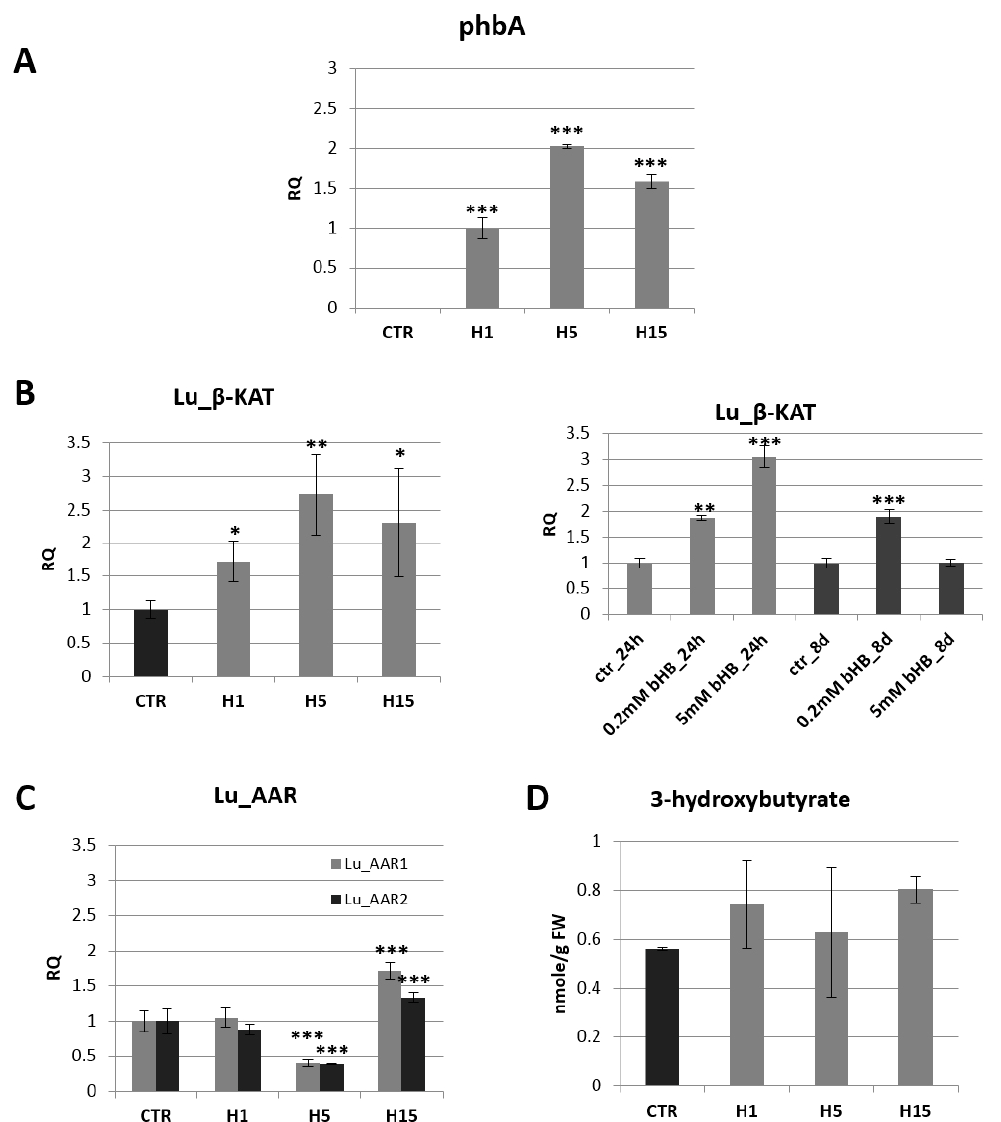
Figure 1. The mRNA level of bacterial beta-ketothiolase (phbA) in transgenic flax plants (H1, H5, H15). Changes in mRNA levels are shown as the relative quantity (RQ) relative to the reference gene ( actin ) in comparison with the expression in H1 plants, where it was the lowest. Non-transgenic control lines (CTR) showed not phbA gene expression. The results were obtained via PCR on cDNA, subsequent electrophoretic separation of obtained products and the densitometric measurement of bands ( A ). The mRNA level of endogenous beta-ketothiolase in transgenic flax lines H1, H5, H15 in comparison with non-transgenic flax (CTR) and in flax treated with the beta-hydroxybutyrate standard at concentrations of 0.2 mM and 5 mM during 24 h and 8 days in relation to non-treated flax (CTR) ( B ). The mRNA level of acetoacetyl-CoA reductases in transgenic flax lines H1, H5, H15 in relation to non-transgenic flax (CTR). The mRNA level of Lu_AAR1, Lu_AAR2 (acetoacetyl-CoA reductases) in transgenic flax in comparison with non-transgenic flax (CTR) was obtained from real-time RT-PCR analysis. Actin was used as a reference gene and the transcript levels were normalized to those of the control plant (CTR). RQ: relative quantity ( C ). Content of beta-hydroxybutyrate in 5-week-old plants (stems and leaves) from in vitro culture of transgenic flax lines H1, H5, H15 and in non-transgenic flax (CTR) determined using the GC-MS technique ( D ). The results are presented as mean values of three independent repeats ± SD. Statistically significant di ff erences are marked with asterisks (*— p < 0.05, **— p < 0.01, ***— p <